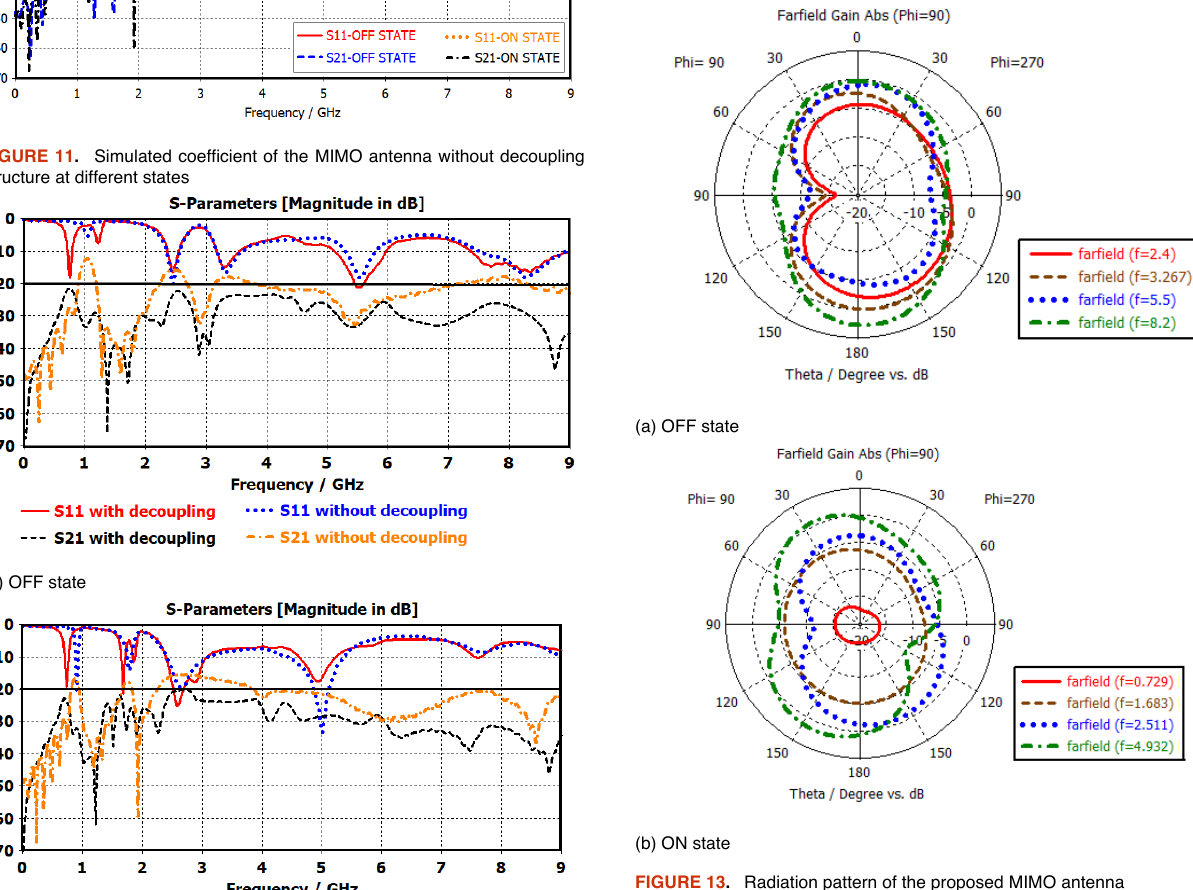
FIGURE 13. Radiation pattern of the proposed MIMO